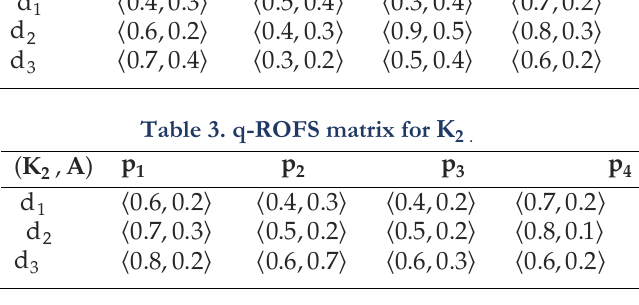
Table 4. q-ROFS matrix for 𝐊